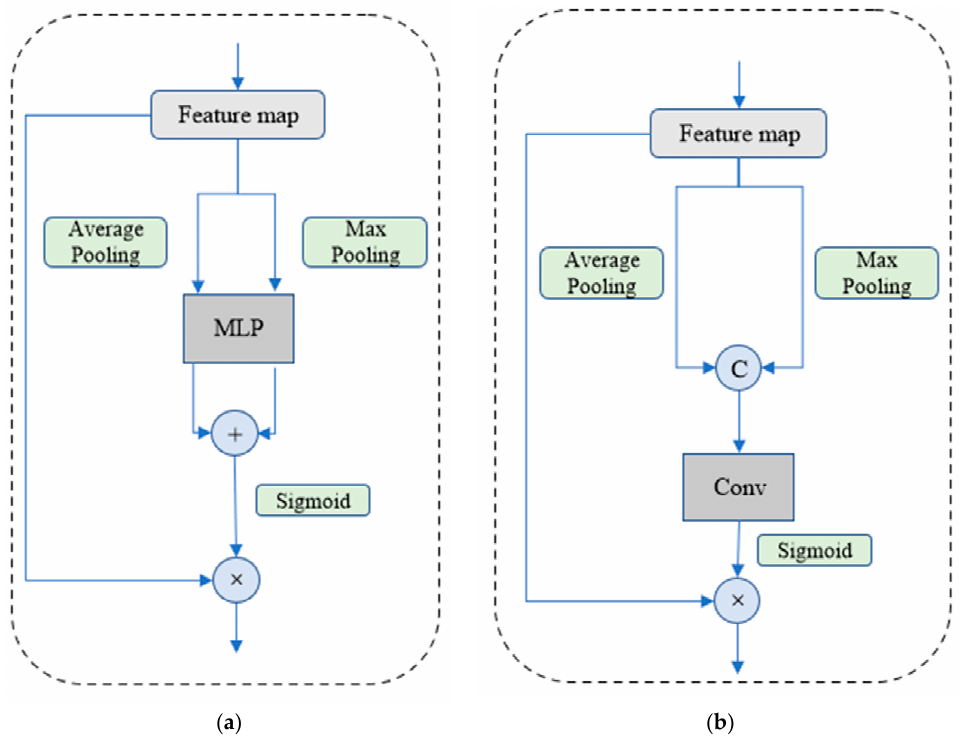
Figure 2. Network architecture of channel attention block ( a ) and spatial attention block ( b ). The channel attention block learns which channels of feature maps are important; the spatial attention block finds out “where” feature maps are vital. Together, MAB can aggregate more effective information regarding categories.